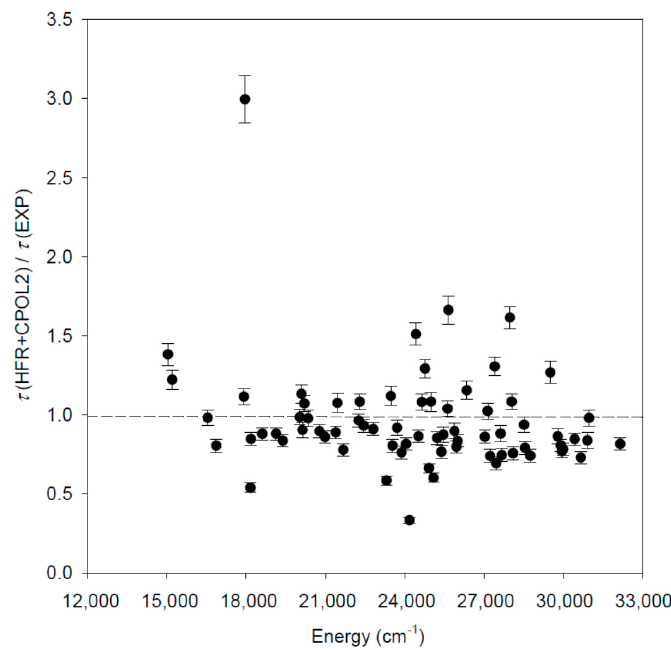
Figure 2. Comparison between the radiative lifetimes ( ô ) computed in the present work using the HFR+CPOL2 model and the most recent laser-induced fluorescence experimental measurements [22]. The dashed line indicates unity.